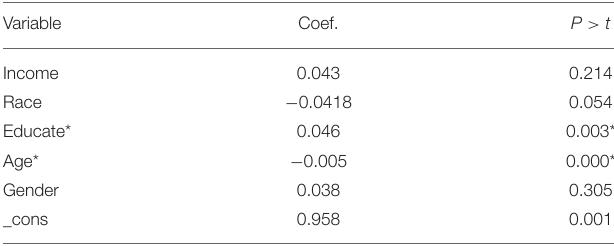
TABLE 5 | Linear Regression model showing the combination variable “Digital Access” as related to Sociodemographic Variables in a Population of 205 Clients of a Low-Cost Veterinary Clinic in Worcester,